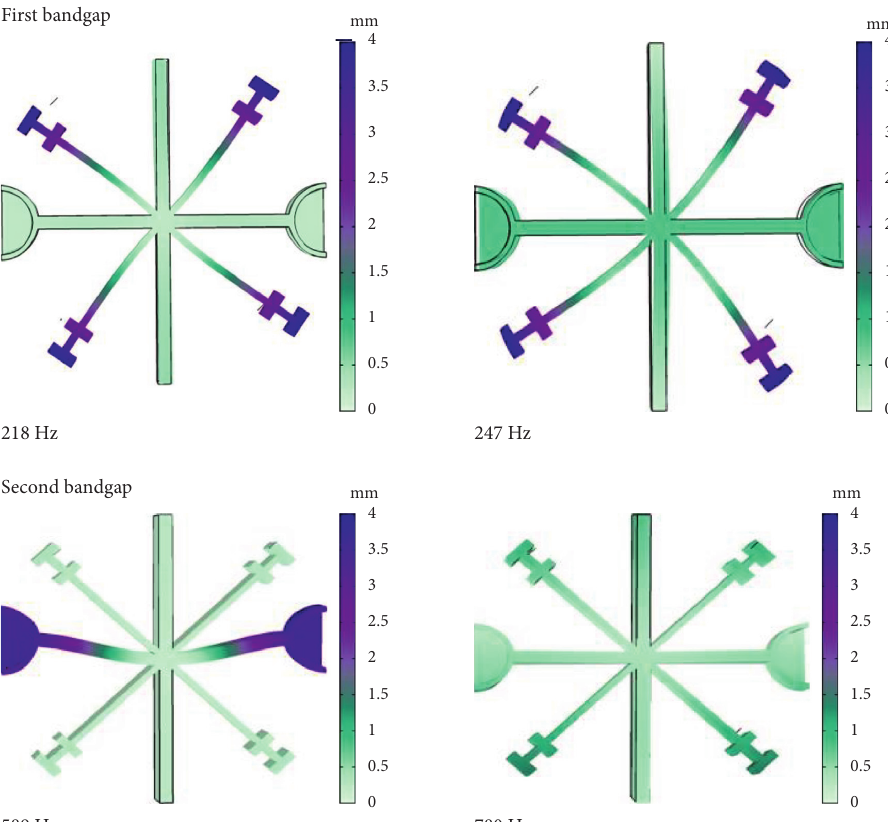
Figure 8: Mode shapes at the edge frequencies of each bandgap obtained using COMSOL model simulations.